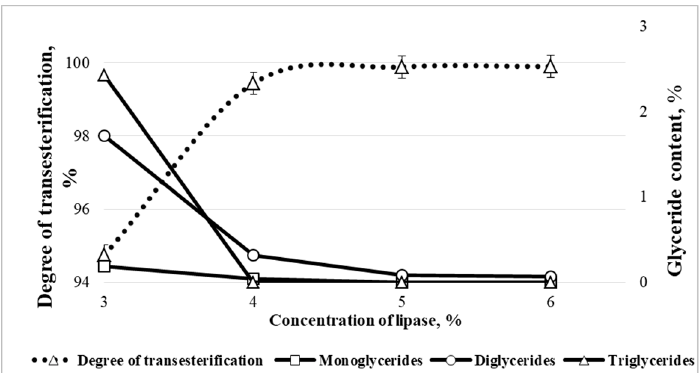
Figure 3. The dependence of degree of transesterification (vertical (value) axis) and glyceride content in biodiesel fuel (secondary vertical (value) axis) on the lipase (Lipozyme TL IM) concentration when the oil-to-ethanol molar ratio is 1:5, the duration of reaction is 7 h and the temperature of reaction is 30 °C.